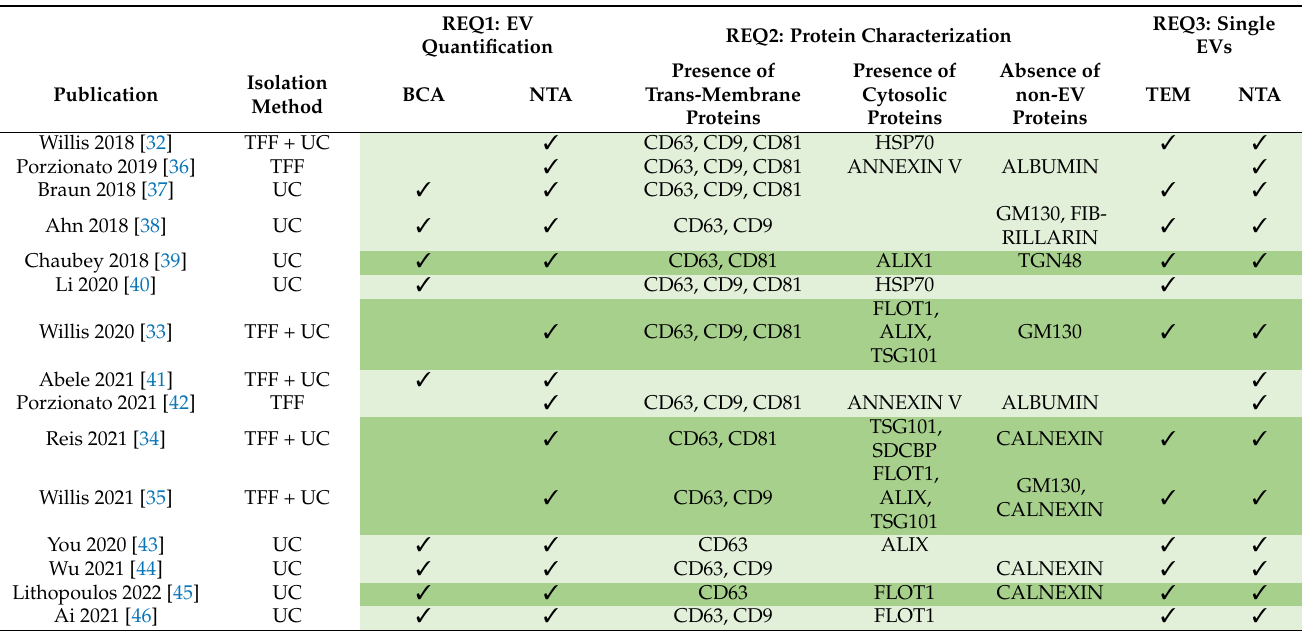
Table 2. EV isolation and characterization methods of current EV-based preclinical studies in models of bronchopulmonary